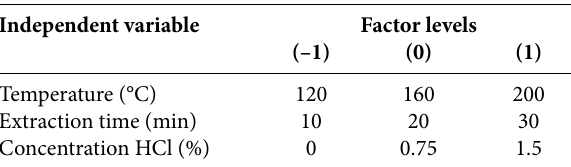
Table 1. Box-Behnken experimental design with natural and coded levels of SWE parameters Independent